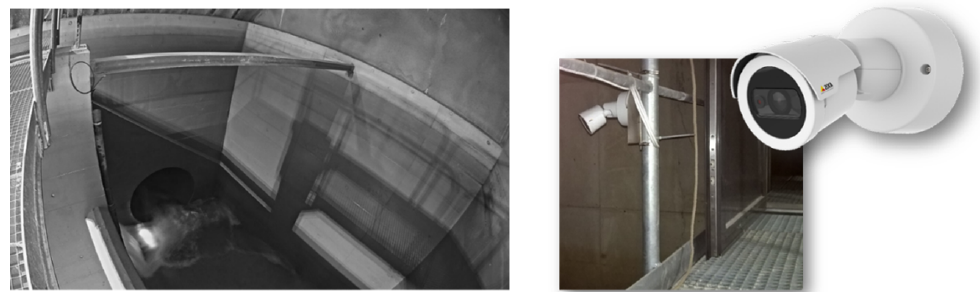
Figure 11. IR camera with an image of the forebay tank